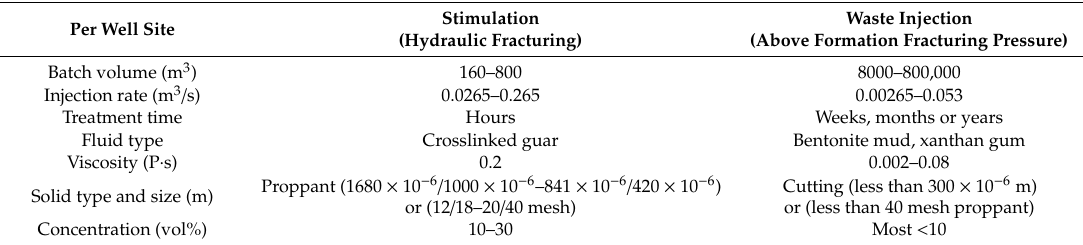
Table 8. Comparison between reservoir stimulations by fracturing and underground drilling waste injection above the formation fracture pressure